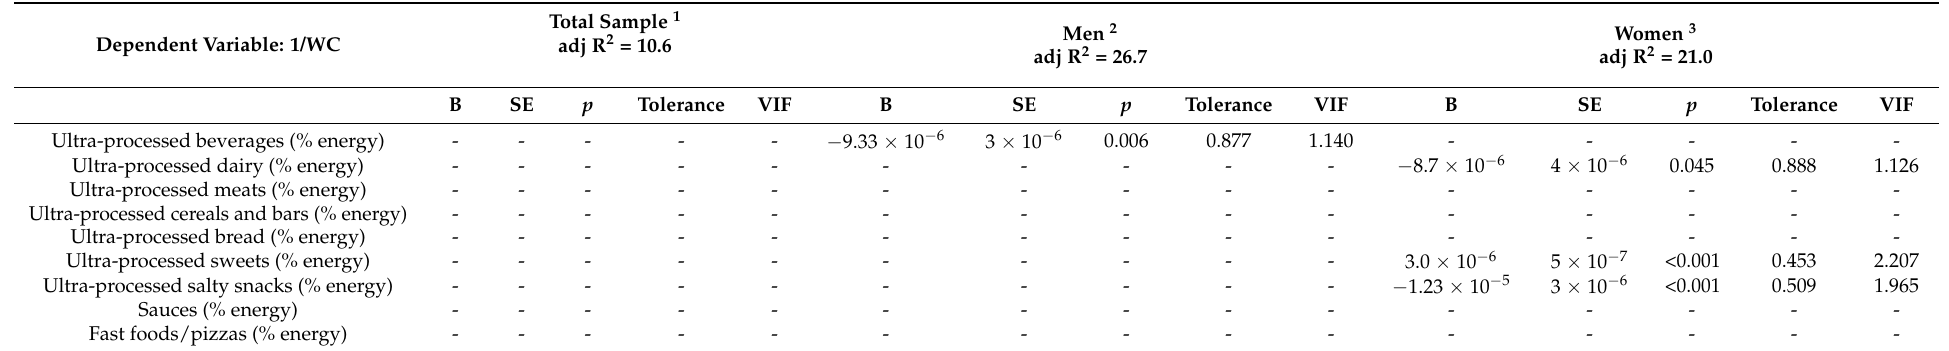
Table 5. Linear regression analysis for 1/WC in the total sample, men and women with processed food groups as independent variables (stepwise linear regression model).